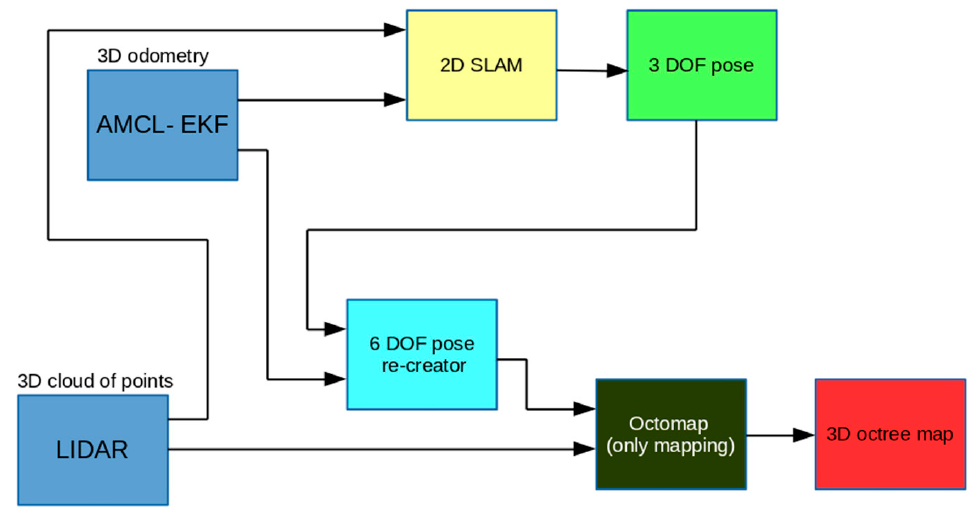
Figure 2. Block diagram of hybrid 3D-map-building bases on 2D SLAM and reduced Octomap algorithms.